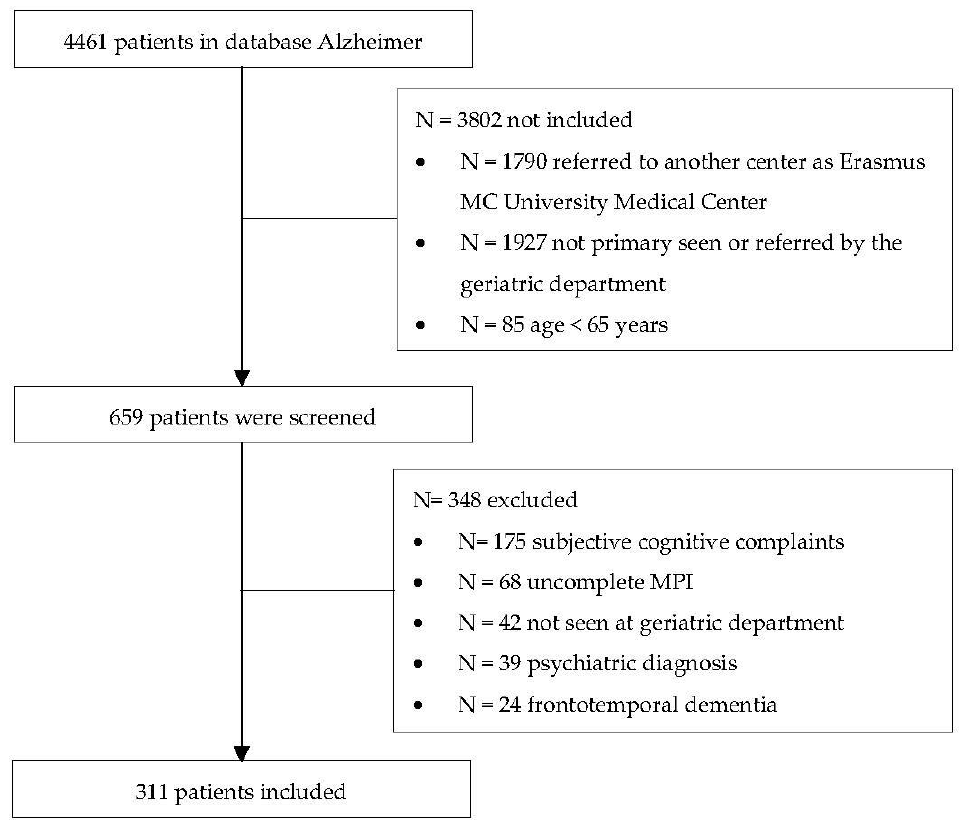
Figure 1. Flow chart of the study.